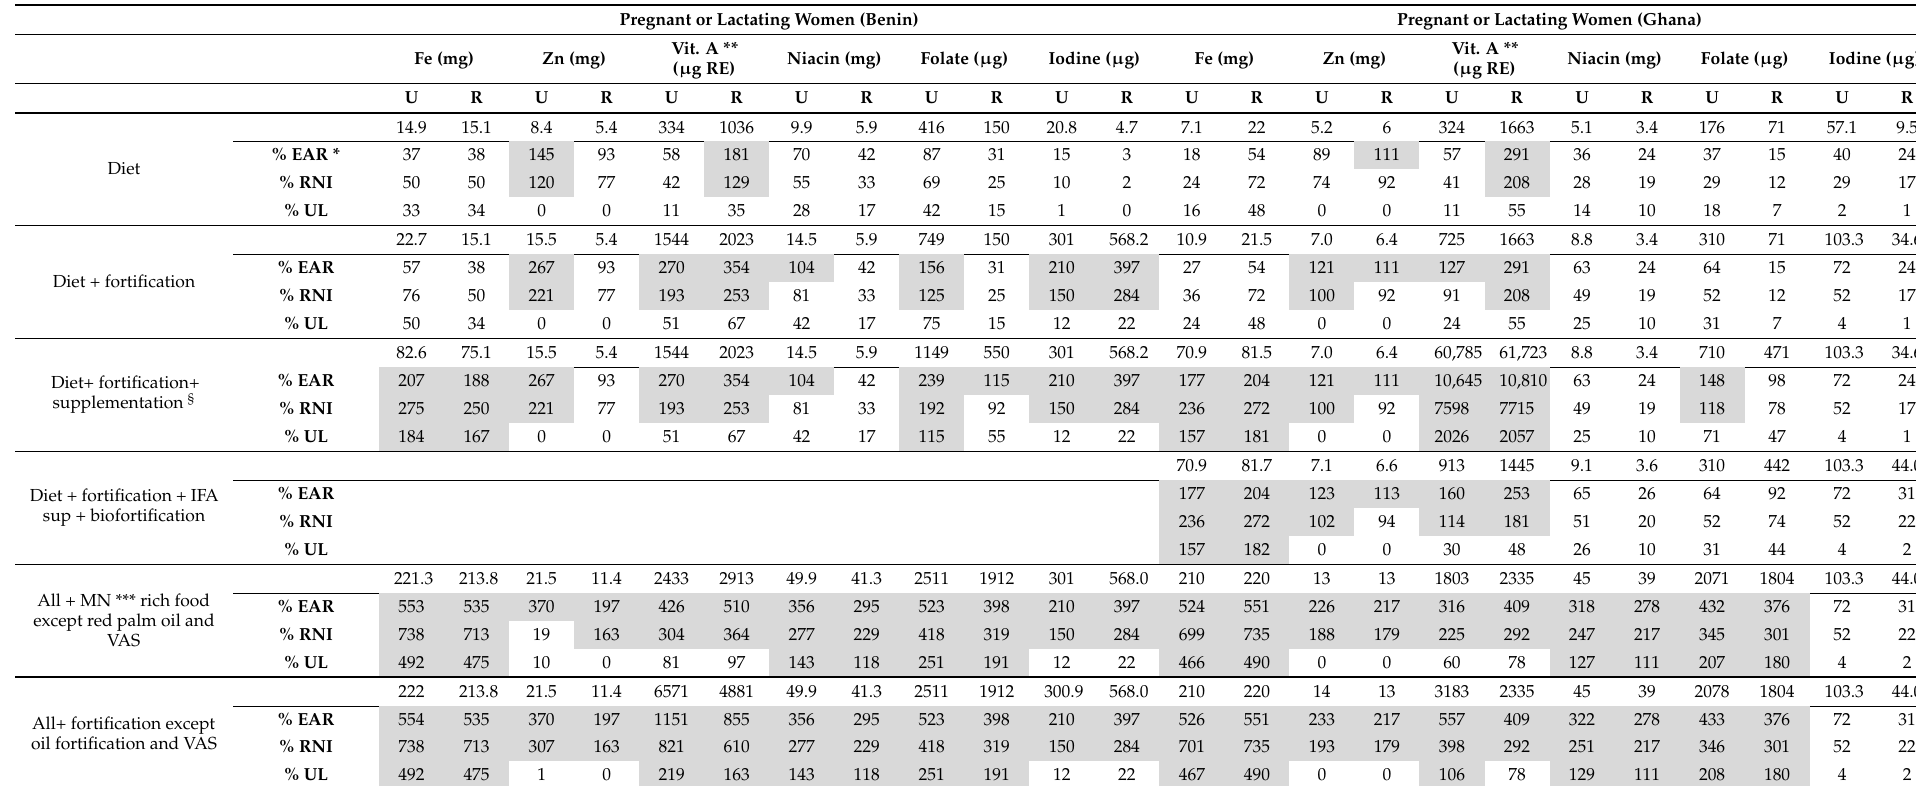
Table 4. Micronutrient intakes from diet and interventions and coverage of recommendations for pregnant or lactating women in Benin and Ghana in urban (U) and rural (R) settings. Shaded cells indicate when recommendations or limits are